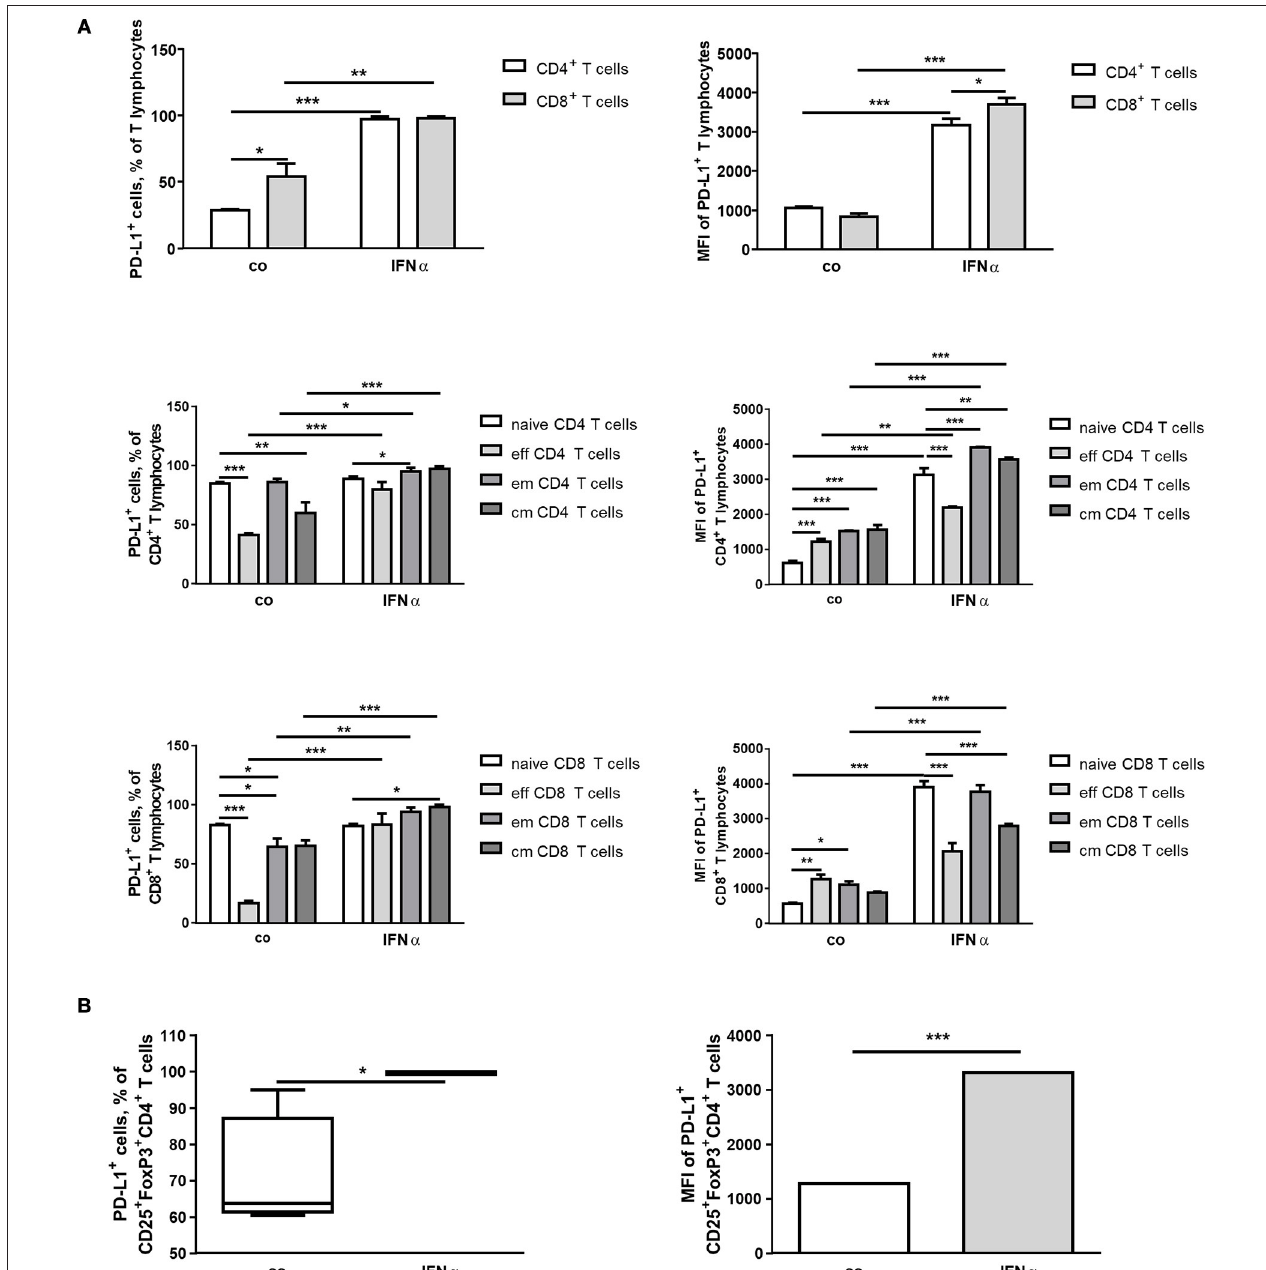
FIGURE 2 | IFN α up-regulates PD-L1 expression on different T-cell populations ex vivo . FACS analysis of PD-L1 expression on the surface of different lymphoid immune cells from spleens of healthy mice. Splenocytes were isolated, treated for 24h with 1,000 U/ml IFN α and investigated by flow cytometry. The results are presented as interleaved bars (A) or as box and whiskers plot or column bar graph (B) and statistically analyzed using two-way ANOVA or unpaired T -tests, n = 4, * p < 0.05, ** p < 0.01, and *** p < 0.001.